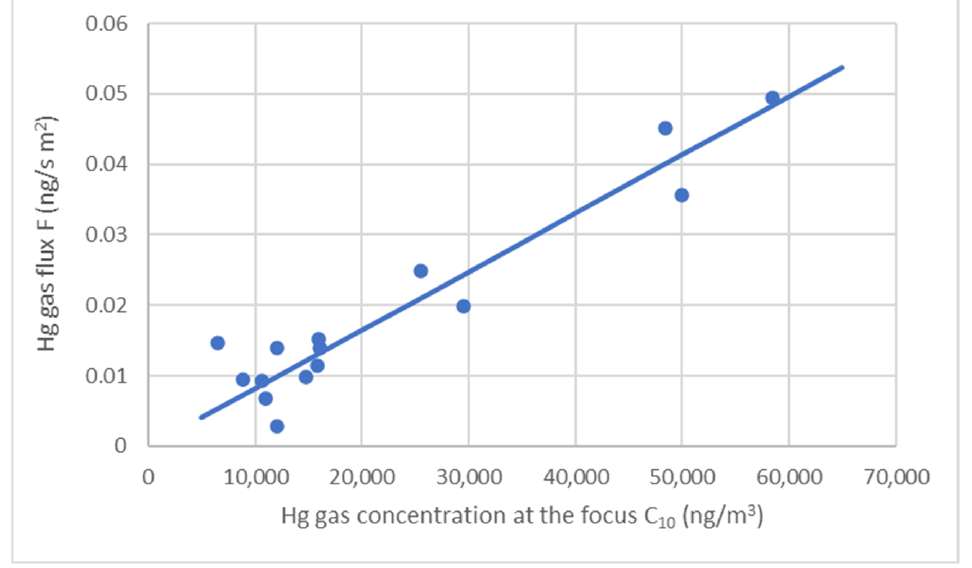
Figure 6. Emission flux vs. concentration at focus C 10.